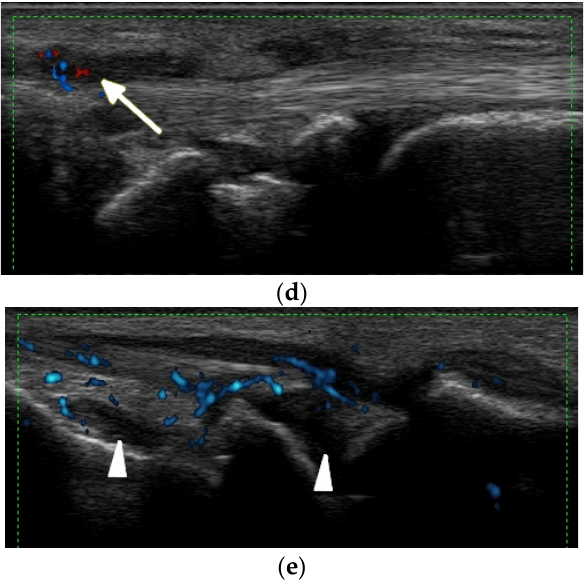
Figure 1. A 34-year-old female with systemic lupus erythematosus. ( a ) Posterior–anterior and oblique ( b ) radiographs of the bilateral hands show a non-united fracture of the right scaphoid waist, with increased sclerosis of the proximal pole and proximal waist consistent with osteonecrosis (arrow), possibly steroid-induced, and with no additional deformities. ( c ) Long-axis power Doppler ultrasound images at the volar aspect of the ring finger, ( d ) dorsal ulnar aspect of the wrist, and ( e ) volar aspect of the wrist show increased synovial vascularity involving the ring finger in ( c ) and the 6th extensor compartment tendon sheath in ( d ), consistent with tenosynovitis (arrows). Synovitis at the volar aspect of the radiocarpal and midcarpal joints without erosive bone changes is seen in ( e ) (arrowheads).